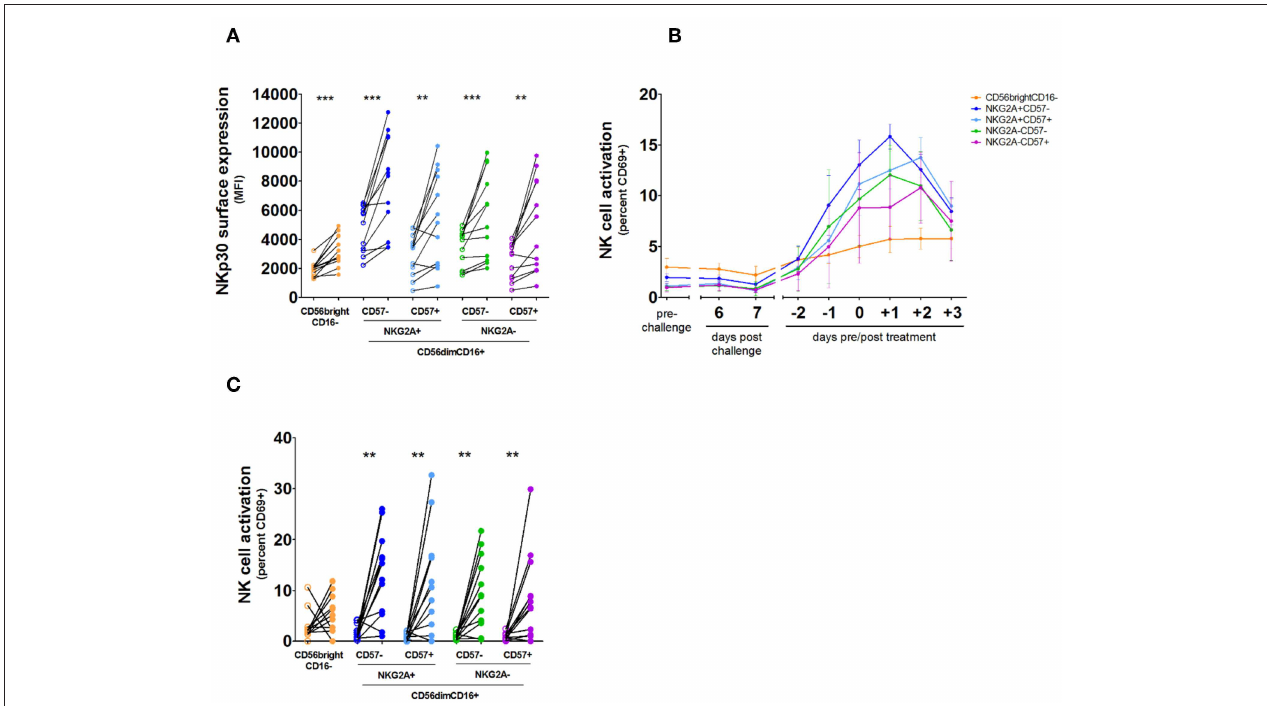
FIGURE 3 | NKp30 expression and activation kinetics on NK cell subsets. NK cells were analyzed by daily flow cytometry in whole venous blood from 12 volunteers undergoing Controlled Human Malaria Infection. Antimalarial treatment was initiated when parasite densities reached levels detectable by microscopy. (A) Total NK cells were divided into five subpopulations based on their surface expression of CD56, CD16, NKG2A, and CD57: CD56 bright CD16– (orange), CD56 dim CD16 + NKG2A + CD57– (dark blue), CD56 dim CD16 + NKG2A + CD57 + (light blue), CD56 dim CD16 + NKG2A-CD57– (green), and CD56 dim CD16 + NKG2A-CD57 + (purple). Surface expression of NKp30 for each NK cell subset prior to malaria infection (open circles) compared with NKp30 expression on each NK cell subset on the day of antimalarial treatment (closed circles). P -values are the result of Wilcoxon matched-pairs signed rank test; ** p < 0.01; *** p < 0.001. (B) The graph shows the mean and error of NK cell CD69 surface expression on each subset per day in 12 volunteers. (C) Surface expression of CD69 was determined for each NK cell subset prior to malaria infection (open circles) and on the day of antimalarial treatment (closed circles). P -values are the result of Wilcoxon matched-pairs signed rank test; * p < 0.05; ** p < 0.01; *** p <